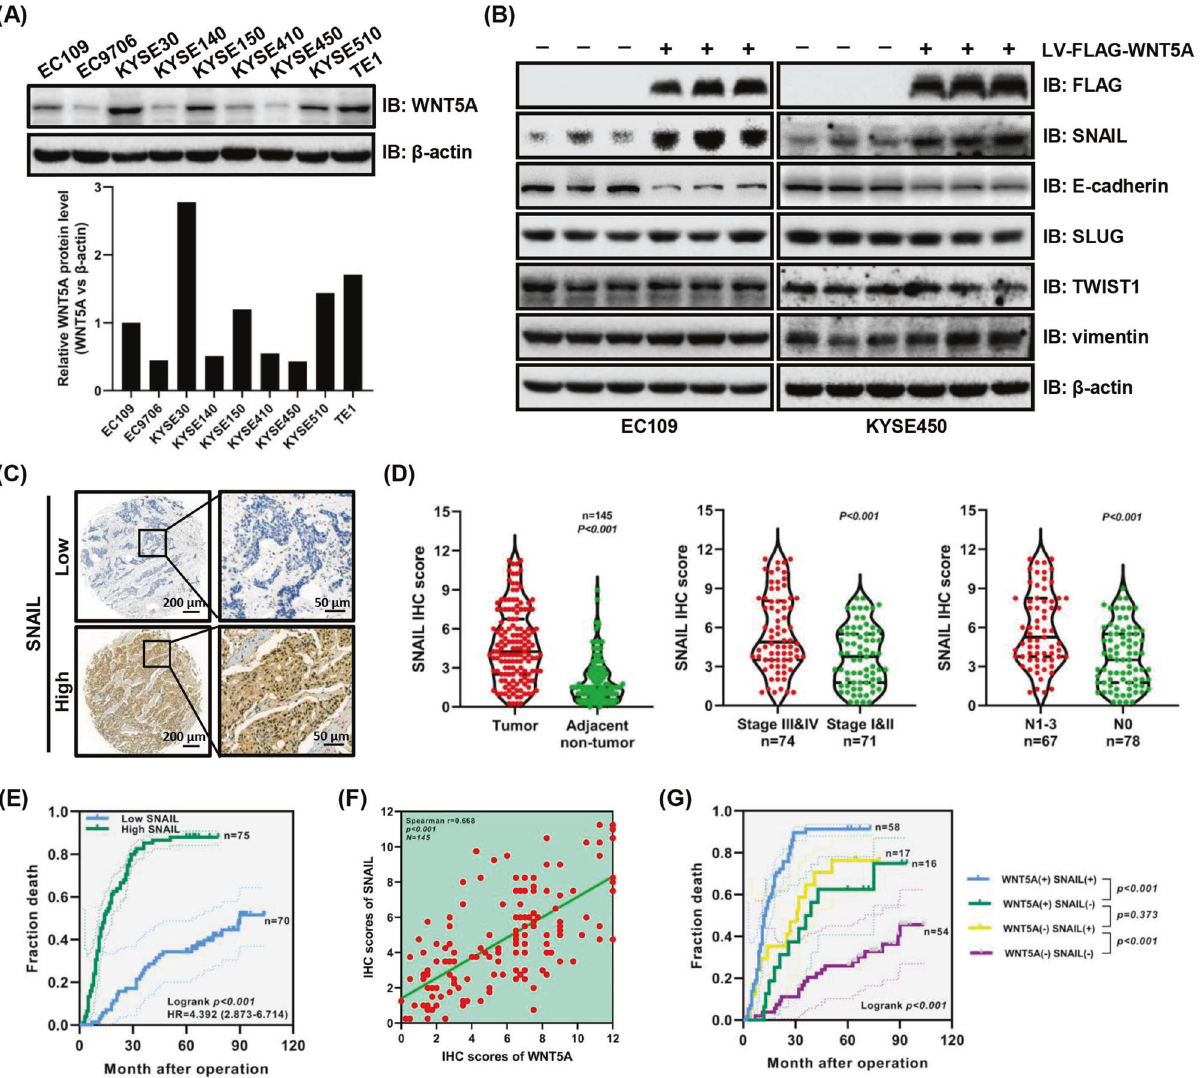
Fig. 2 SNAIL levels are signi fi cantly upregulated with WNT5A overexpression and correlate with a poor prognosis. A Western blots showing WNT5A levels in various ESCC cells. B Representative western blots showing the levels of FLAG-WNT5A, SNAIL, E-cadherin, SLUG, TWIST1, and vimentin in WNT5A-overexpressing cells. β -actin was used as an internal control. C Representative IHC images showing SNAIL expression in ESCC tissues. Scale bars, 200 and 50 μ m (inset). D Statistical analysis of SNAIL expression in 145 patients with ESCC based on the tissue microarray IHC results. E Kaplan – Meier survival analysis of 145 patients with ESCC presenting high/low SNAIL expression. F Correlation analysis of WNT5A and HDAC7 expression in ESCC tissues. G Comprehensive Kaplan – Meier survival analysis of 145 patients with ESCC presenting high/low WNT5A and SNAIL expression. LV